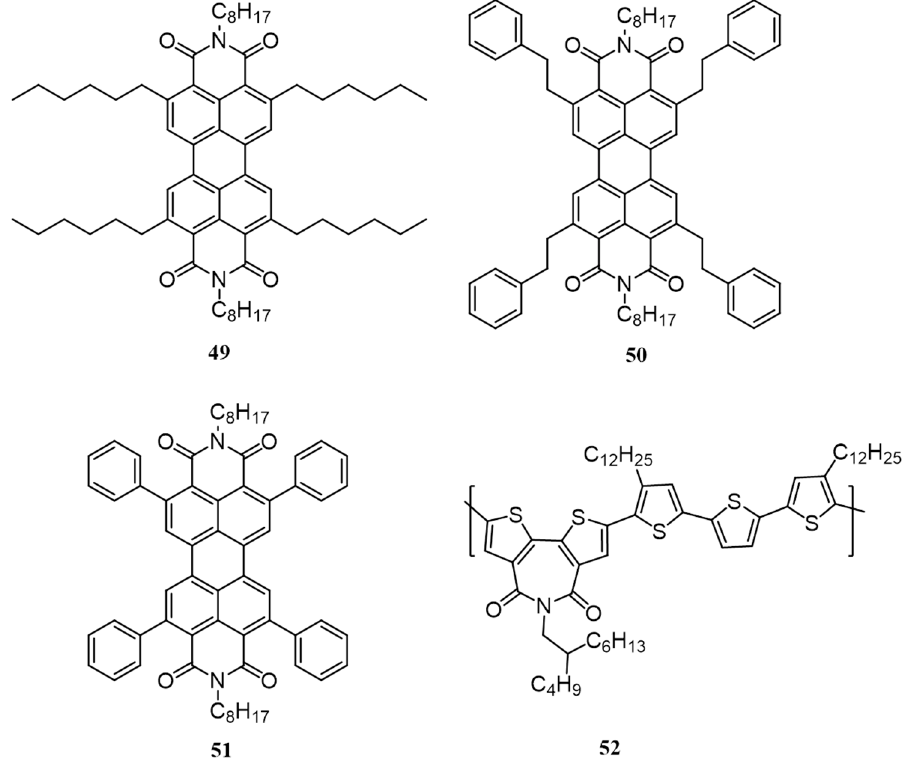
Figure 18. The chemical structures of 49 – 52 synthesized by Wasielewski et al. [74].